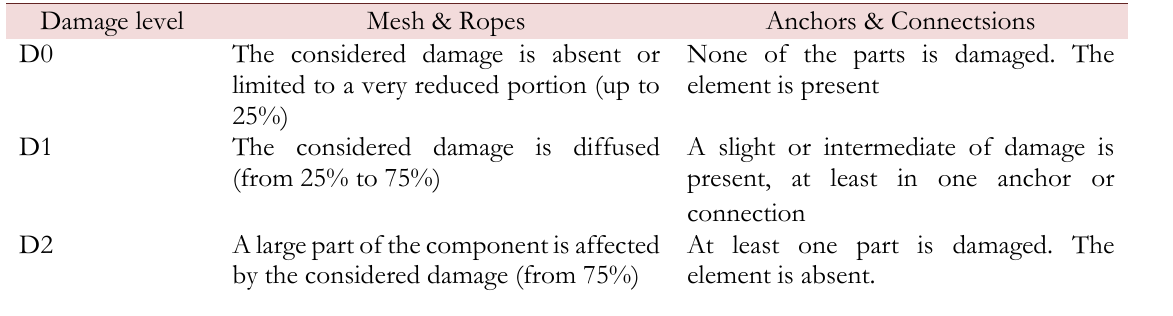
Table 5: Damage levels on the components of a drapery